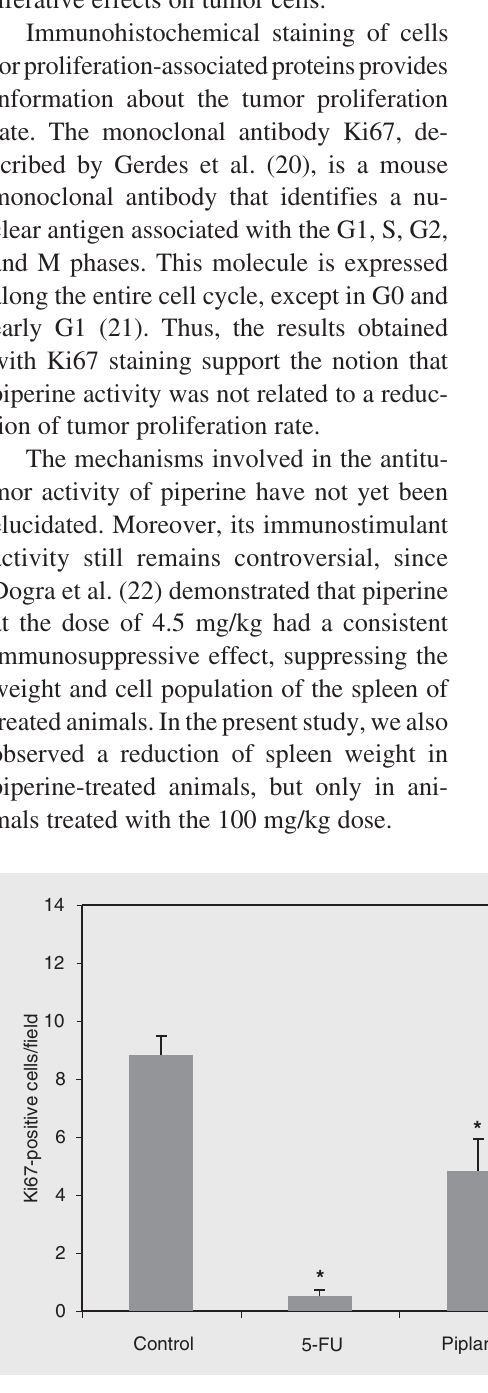
Figure 2. Effect of antitumor substances on the cell proliferation of Sarcoma 180 cells. The mice received 25 mg kg -1 day -1 5-fluorouracil (5-FU) and 100 mg kg -1 day -1 piperine and piplartine for 7 days. Ki67-positive cells from 4-6 fields/tumor were counted. Data are reported as the mean ± SEM number of positive cells/field for 10 mice in each group. *P < 0.05 compared to control (ANOVA followed by the Student-Newman-Keuls